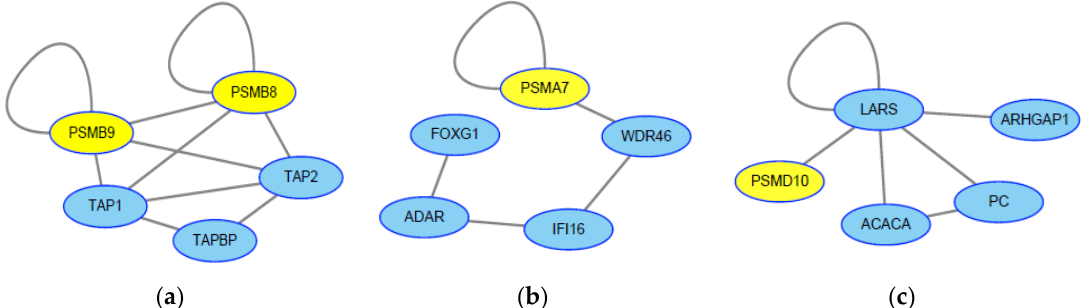
Figure 4. Significant subnetworks associated with encephalitis. ( a ), ( b ) and ( c ) represent different subnetworks related to encephalitis. The genes marked by yellow belong to the ubiquitin proteasome system (UPS).